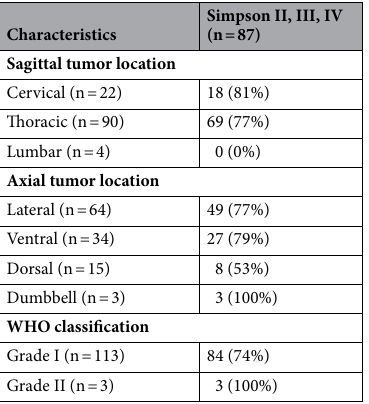
Table 3. Characteristics of cases treated with Simpson II, III or IV resection (n = 87).